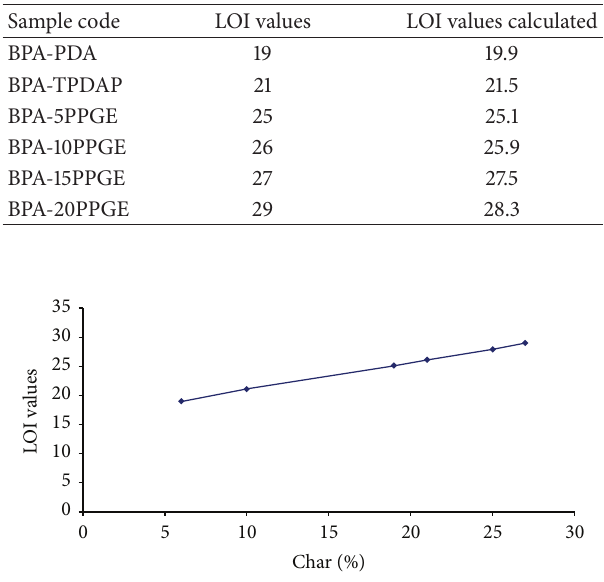
Table 4: LOI values of epoxy-PPGE films.